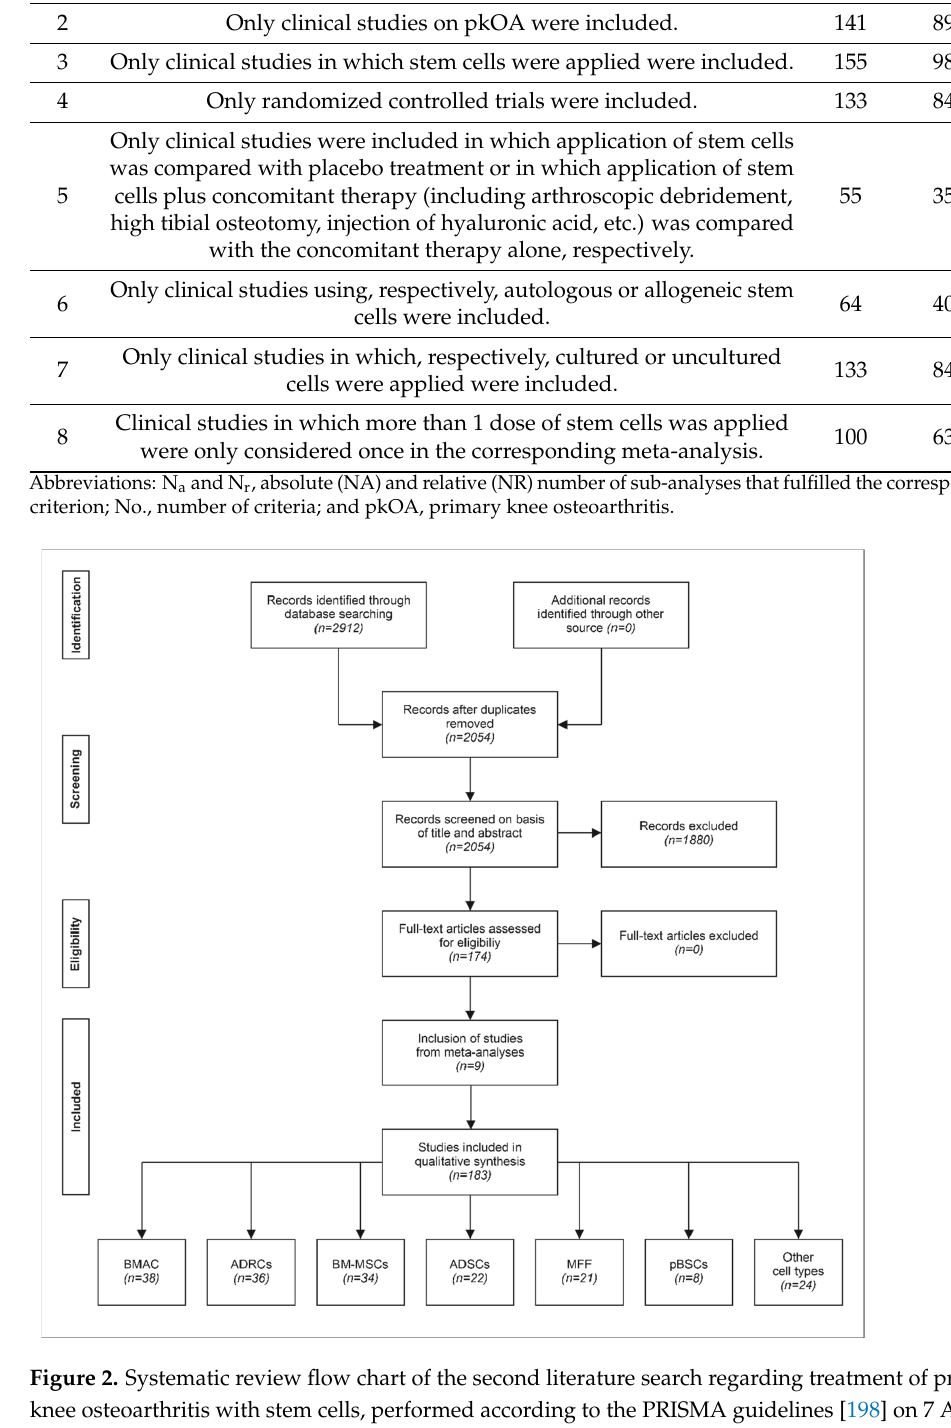
Table S2 of studies in which treatment of primary knee osteoarthritis with different types of stem cells was investigated. No.